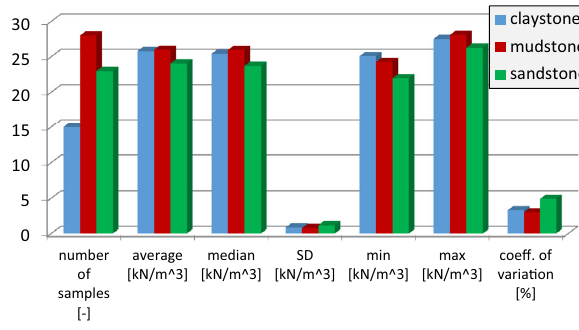
Fig. 8 Comparison of chosen statistical parameters for unit